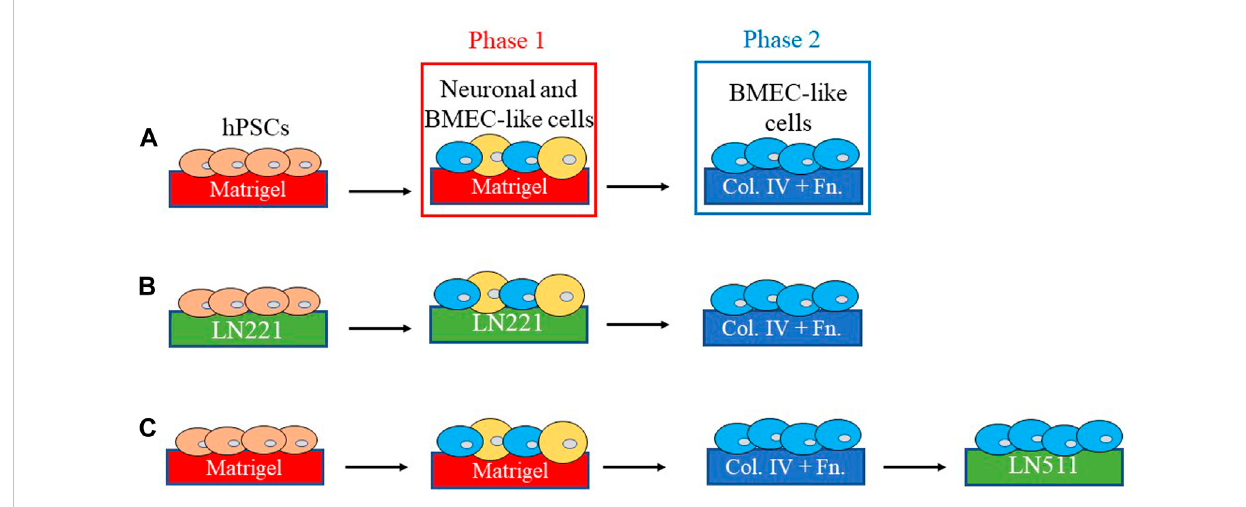
FIGURE 2 Schematics of differentiation and characterization of hPSC-BMEC like cells. (A) BMEC-like cells can be derived from human pluripotent stem cells (hPSCs) by fi rst co-differentiating hPSCs to neural cells and BMEC-like cells on plates coated with Matrigel, then purifying and maintaining endothelial cells on endothelial-selective collagen IV/ fi bronectin (C4/Fn)-coated surfaces such as Transwell inserts for transendothelial electrical resistance (TEER) measurement(Lippmannetal.,2012). (B – C) SchematicsofexperimentalsetupsforstudiesonhowlamininisoformsaffecthPSC-BBBmodels.Itwas found that laminin isoforms 221 and 511 can replace or supplement Matrigel in hPSC-BMEC differentiation phase 1(Aoki et al., 2020) and C4/Fn in phase 2(Motallebnejad and Azarin, 2020), respectively, for improved hPSC-BMEC characteristics such as higher TEER and lower